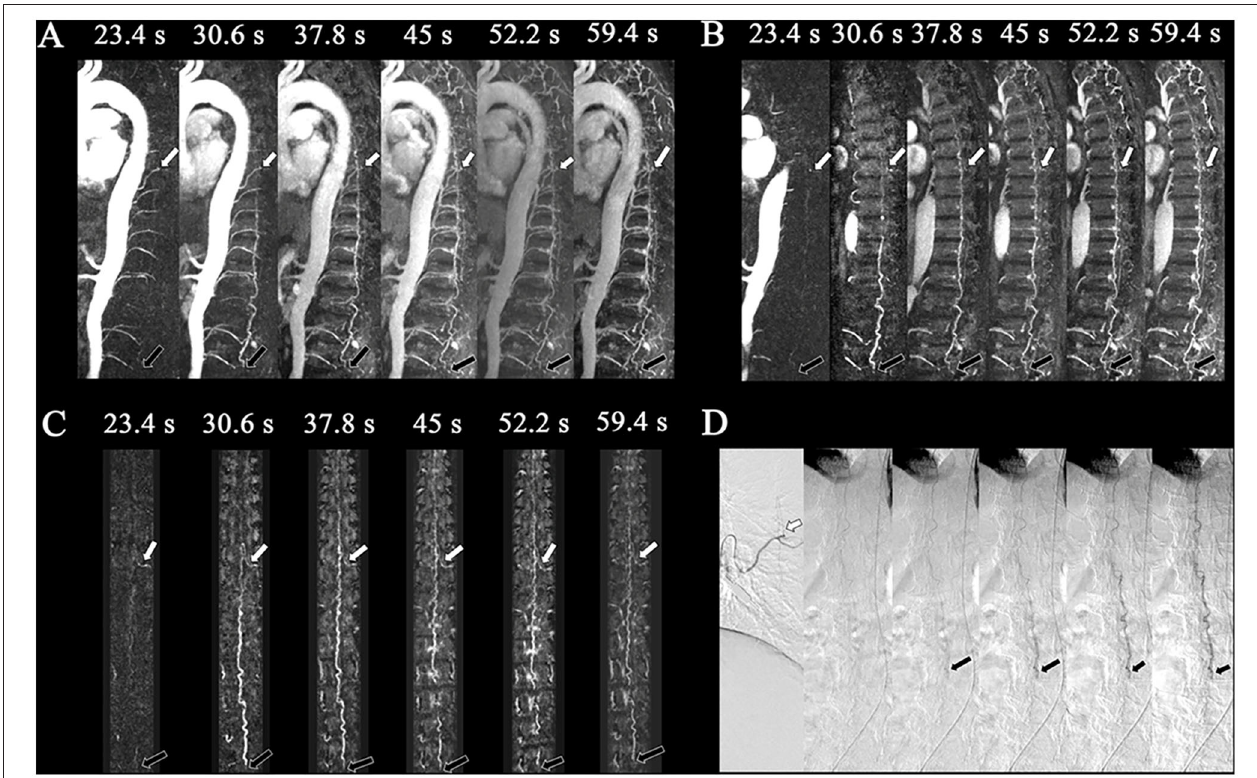
FIGURE 3 | Perimedullary arteriovenous fistula (PAVF) in a 58-year-old patient. Comparison of the visualization capabilities of magnetic resonance angiography and digital subtraction angiography (DSA). (A) The dynamic sagittal maximum intensity projections (MIPs) of the time-resolved angiography with stochastic trajectories (TWIST) examination. In the first phase, the feeding artery that originated from T8 (white arrows) was clearly shown, and then the drainage vein was developed on the following phase with the fistula (L4, black arrows). The length of the dilated vein was also displayed. (B) The dynamic target sagittal MIPs of the TWIST examination. In the first phase, the feeding artery that originated from T8 (white arrows) was clearly shown, and then the drainage vein was developed on the following phase with the fistula (L4, black arrows). (C) The dynamic target coronal curved planar reformation MIPs of the TWIST examination. The feeding artery (T8, left, white arrows) and fistula (L4, black arrows) were displayed clearly. (D) DSA was performed, which confirmed the diagnosis of perimedullary arteriovenous fistula with the feeding arteries that originated from the intercostal artery of T8 (white arrows) and fistula located at L4 (black